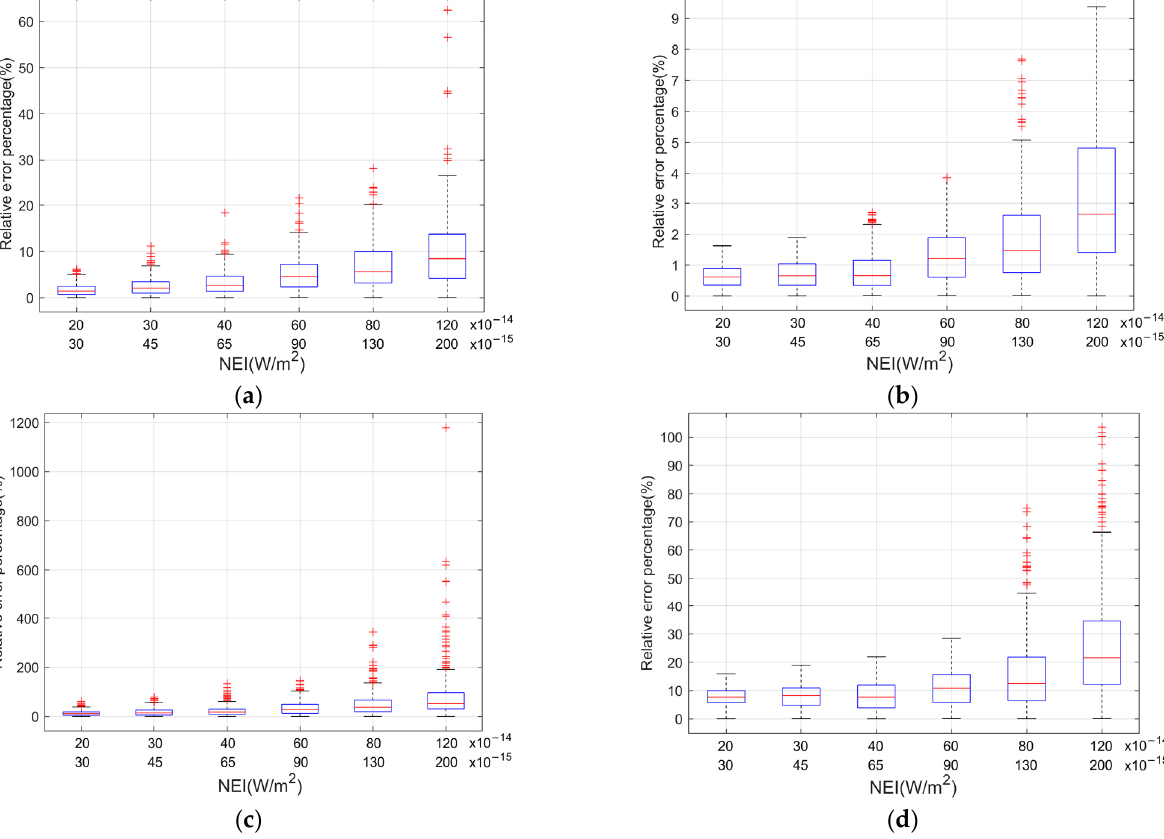
Figure 14. Box diagram of error of features by using DBT and DA-VMD-DBT. ( a ) Temperature error of DBT; ( b ) temperature error of DA-VMD-DBT; ( c ) emissivity-area product error of DBT; ( d ) emissivity-area product error of DA-VMD-DBT. Table 8. The results of evaluation indexes of the feature extraction of simulated radiation signal (8– 12/3–5 µm).